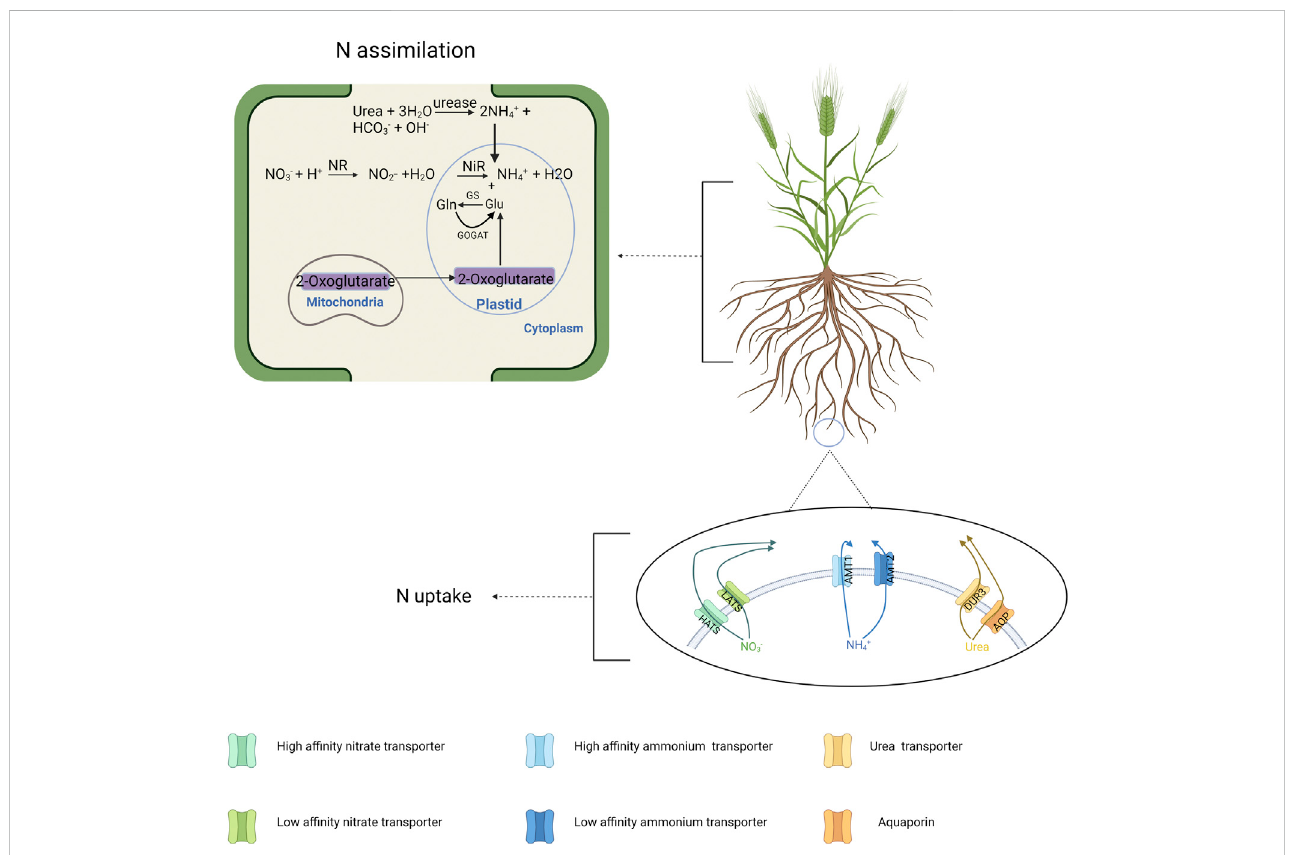
FIGURE 1 N transport and assimilation in the barley plant at a cellular level. In the transport process, different forms of N including nitrate, ammonium and urea are transported via different classes of proteins in different concentrations. In the assimilation process, the conversion of nitrate and urea into ammonium